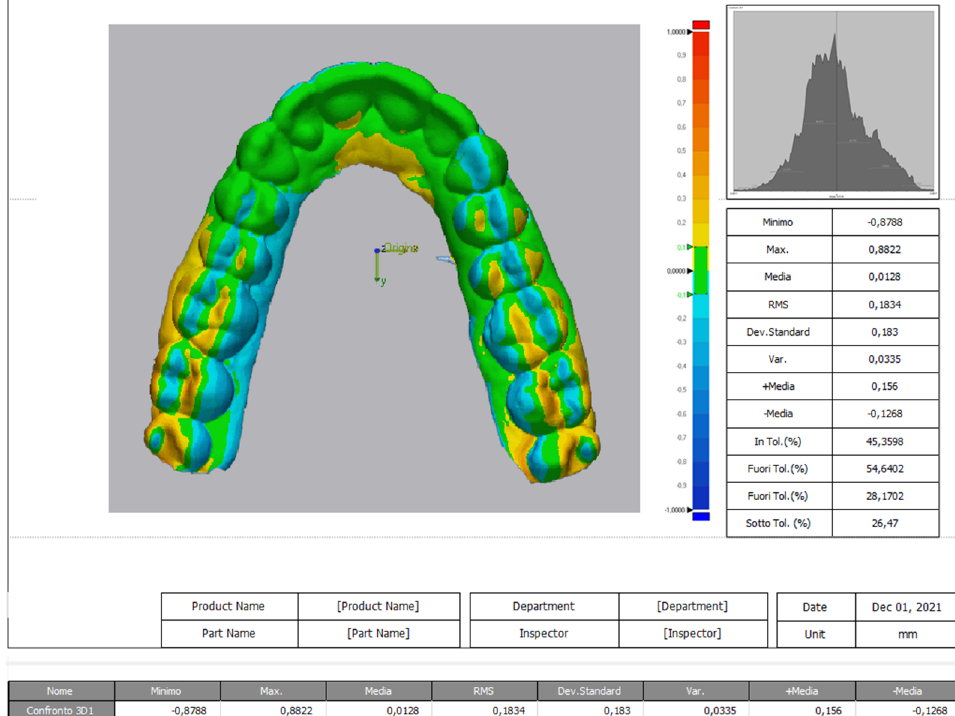
Figure 2. Superimposing the mesh with the Geomagic software. Each aligner’s linear deformation was calculated as the mean of the discrepancies found on superimposing the two scans obtained at T0 and T2. The software generated two types of data: (1) a central indicator; and (2) the deformation variability, or the standard deviation of the deformations at T0 and T2, corresponding to the differences in expansion or contraction between the different points recorded by the system. Weight differences were calculated as the difference between the weights recorded at T0 and T2. Dimensional change and weight change were expressed as medians and interquartile ranges (IQR),